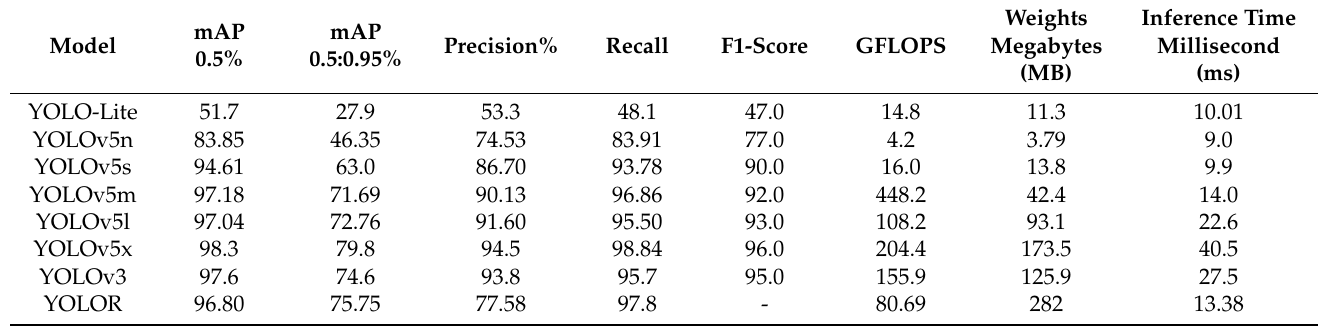
Figure 9. Performance comparison of mAP@0.5, mAP@0.5:0.95, precision and recall. The IoU threshold mAP@0.5 means the average precision when the IoU > 0.5, and the mAP@0.5:0.95 denotes the average precision when the IoU has taken 10 values between 0.5 and 0.95. These charts represent YOLOv5x, YOLOv5l, YOLOv5m, YOLOv5s, YOLOv5n, YOLOv3, YOLO-Lite, and YOLOR separately. Table 4. Comparison of YOLO-Lite, YOLOv5n, YOLOv5s, YOLOv5m, YOLOv5l, YOLOv5x, YOLOv3, and YOLOR Models.